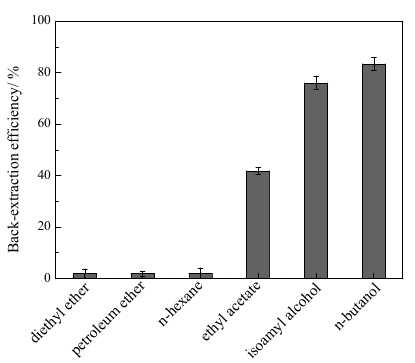
Figure 6. The back-extraction efficiencies for flavonoids using different organic solvents.